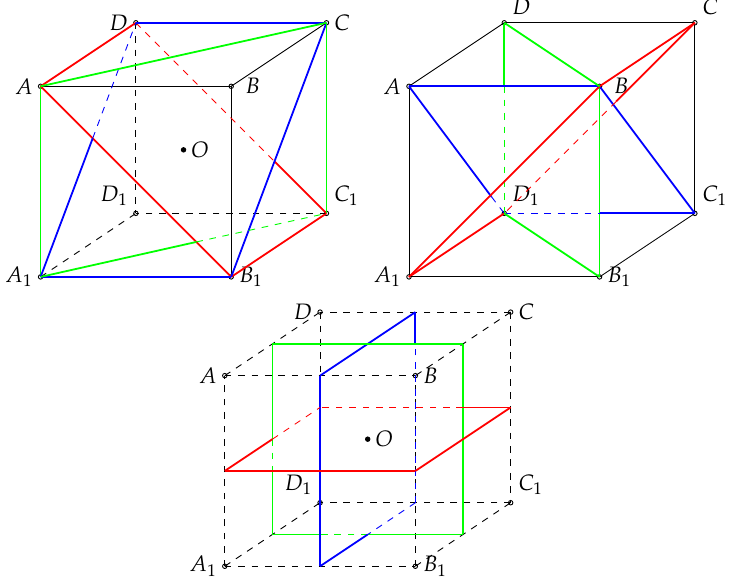
Figure 1. Real 3—symmetry hiperplanes.